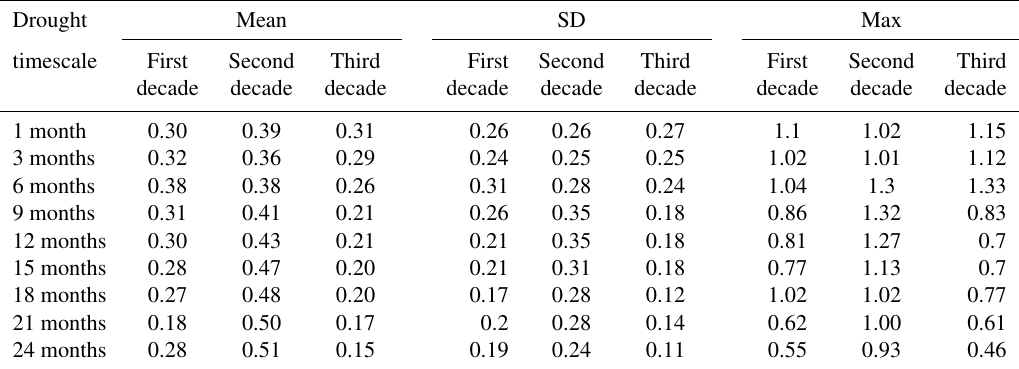
Table 3. Statistics of the severity of drought for 1- to 24-month drought timescale for first decade (1982–1991), second decade (1992–2001), and third decade (2002–2011). SD is the standard deviation, and max is the highest magnitude of drought occurrence. Drought Mean SD